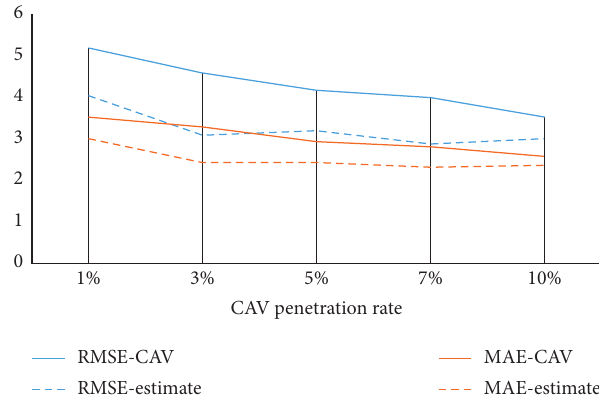
Figure 9: Accuracy comparison between estimated speeds and CAV speeds.